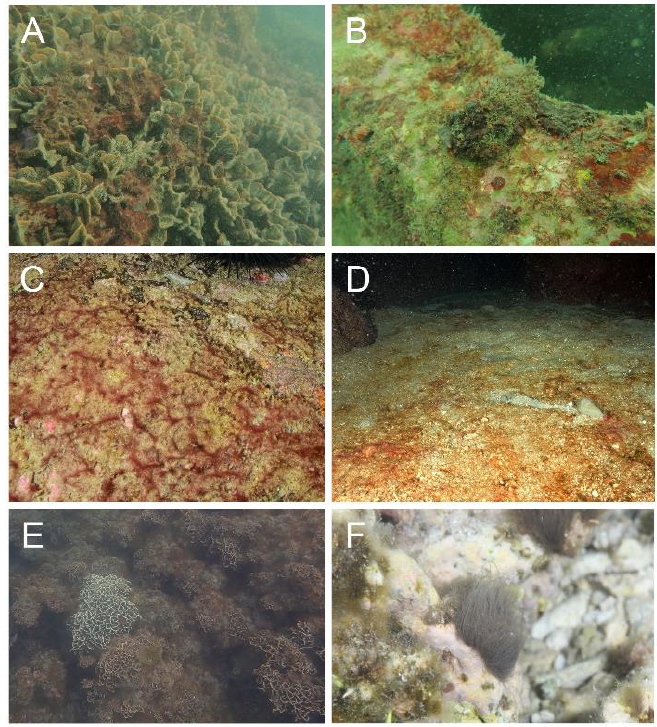
Figure 2. Macroscopic view of the benthic cyanobacterial mats (BCMs). ( A , B ) BCMs at site BG. ( C , D ) BCMs at site LQ. ( E , F ) BCMs at site SLK.